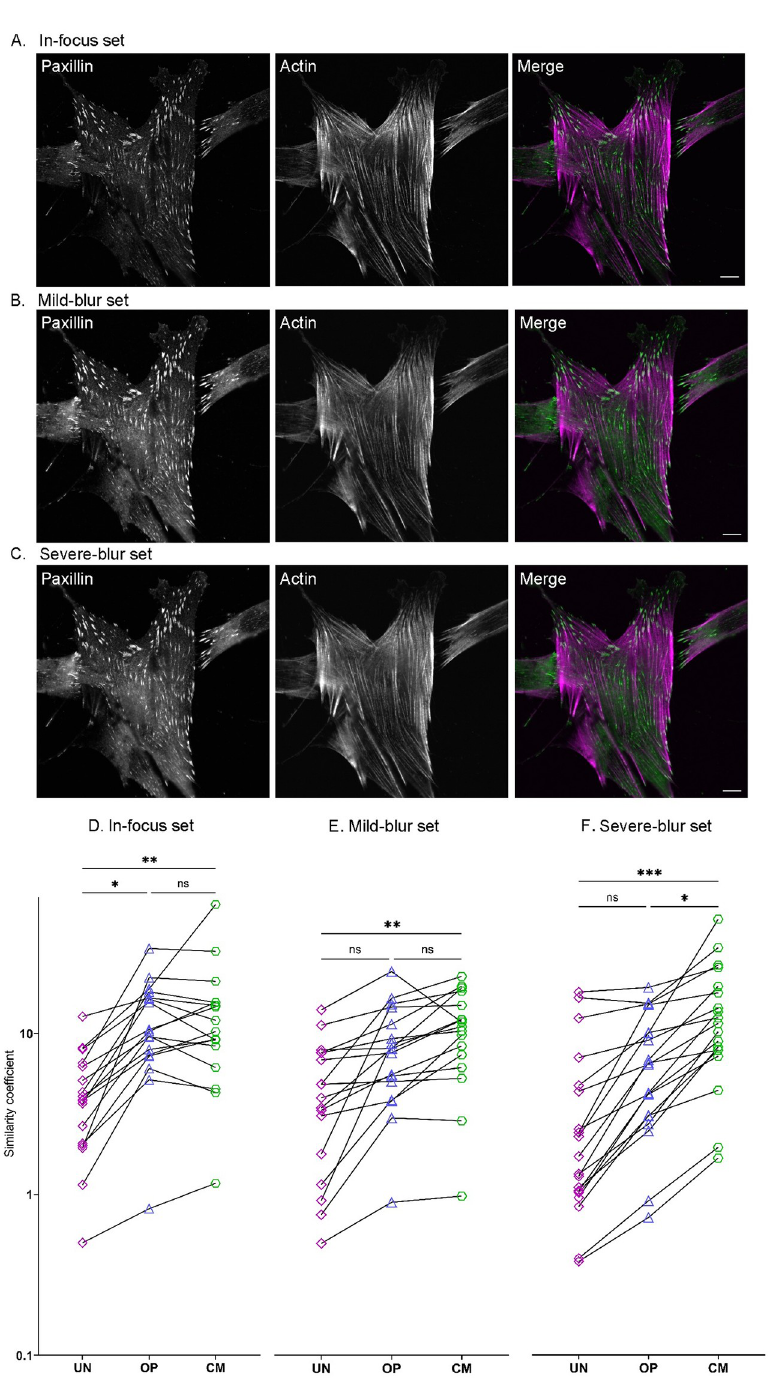
Fig 5. Datasets’ imaging conditions and similarity coefficients ( SC ) for the datasets by level of optimization. A-C) Representative images of MRC5 cells fluorescently stained for actin filaments (phalloidin) and adhesions (paxillin) is shown. Scale bar—10 μ m. All images were taken with a confocal microscope and are of the ventral plane of the cell. (Left) Grayscale image of the adhesions (Center) Grayscale image of actin filaments (Right) Merged image of the cell with actin filaments in magenta and adhesions in green. A) In-focus setting. B) Mild-blur setting. C) Severe-blur setting. D) SC on the y-axis (logarithmic scale) for unoptimized ‘UN’ (purple squares), optimized ‘OP’ (blue triangles) and for customized ‘CM’ (green hexagons) output of analyzed images of the in-focus set (n = 17, UN SC ¼ 4 : 53 , OP SC ¼ 12 : 73 and CM SC ¼ 14 : 83 ), E) Mild-blur set (n = 17, UN SC ¼ 4 : 47 , OP SC ¼ 7 : 98 and CM SC ¼ 10 : 13 ) and F) Severe-blur set (n = 19, UN SC ¼ 3 : 47 , OP SC ¼ 5 : 94 and CM SC ¼ 11 : 74 ). ��� p < 0.001; �� p < 0.01; � p < 0.05 and ns stands for not significant (p > 0.05). https://doi.org/10.1371/journal.pone.0250749.g005 PLOS ONE | https://doi.org/10.1371/journal.pone.0250749 September 10,